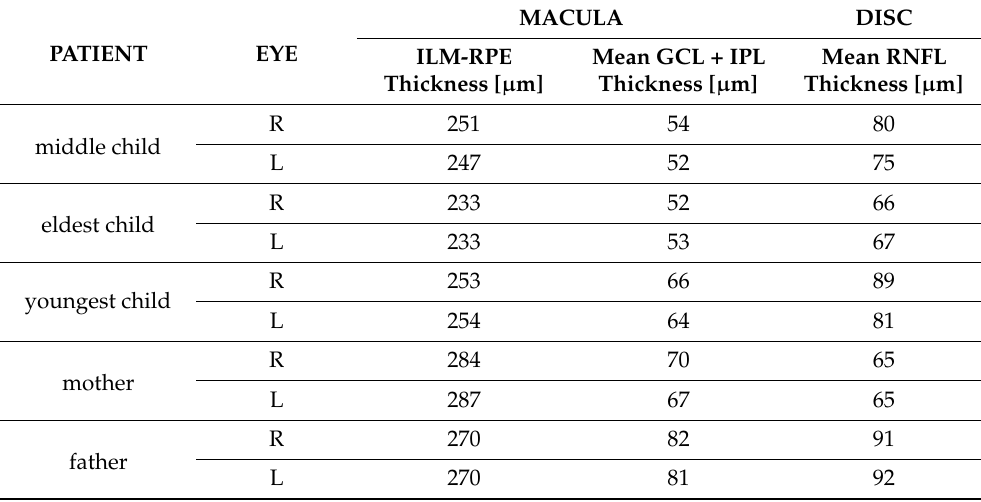
Table 4. Optical Coherence Tomography-thickness of Internal Limiting Membrane-Retinal Pigment Epithelium (ILM-RPE), Ganglion Cells Layer and Inner Plexiform Layer (GCL + IPL), Retinal Nerve Fiber Layer (RNFL); R—right eye; L—left